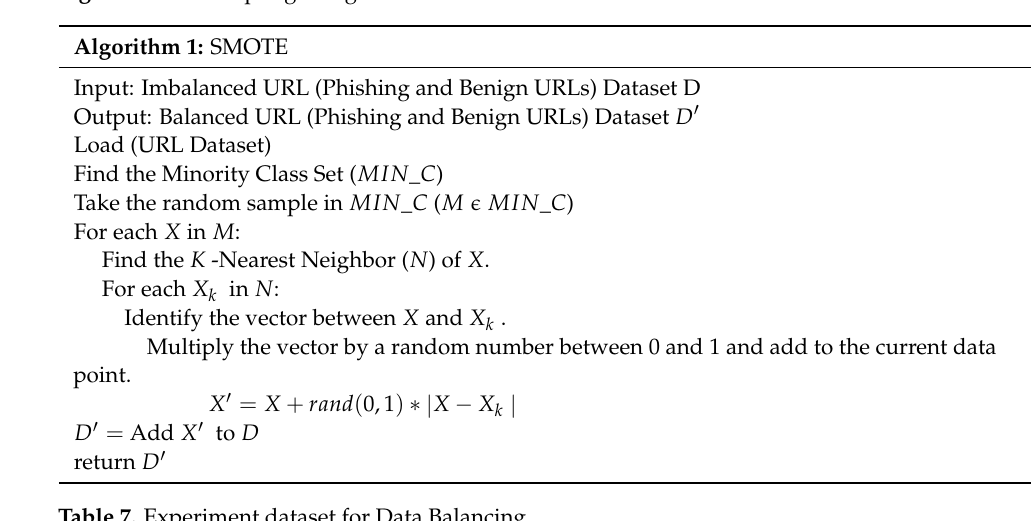
Figure 2. Oversampling using SMOTE.